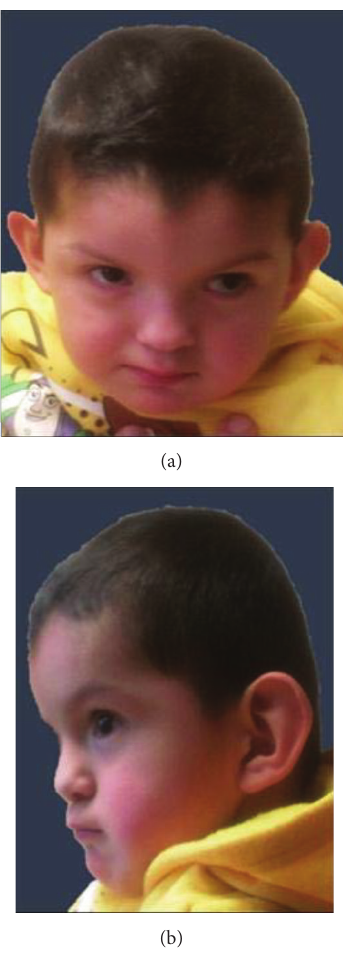
Figure 1: Phenotypic facial features of our patient at the first eval- uation in the Driscoll Children’s Hospital McAllen Genetics Clinic at 29 months of age. Notable findings include brachycephaly, inner canthal distance of 31mm (90th centile for age), and prominent lower face and right ear protruded more than left